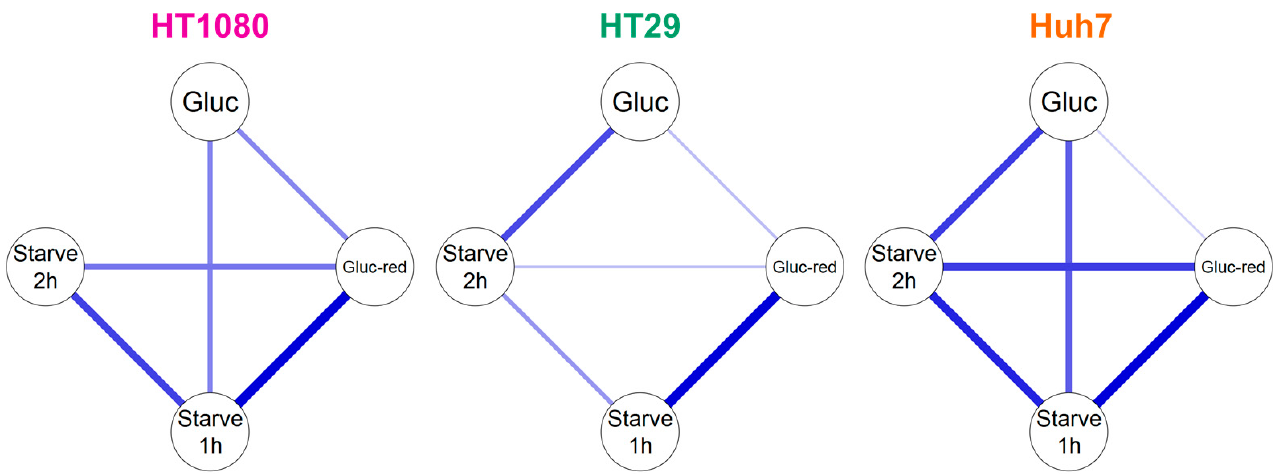
Figure 4. Graphical Gaussian model of 2-[ 18 F]FDG metabolism in HT1080, HT29 and Huh7. Blue lines show positive correlations. The thicker the line, the higher the correlation.